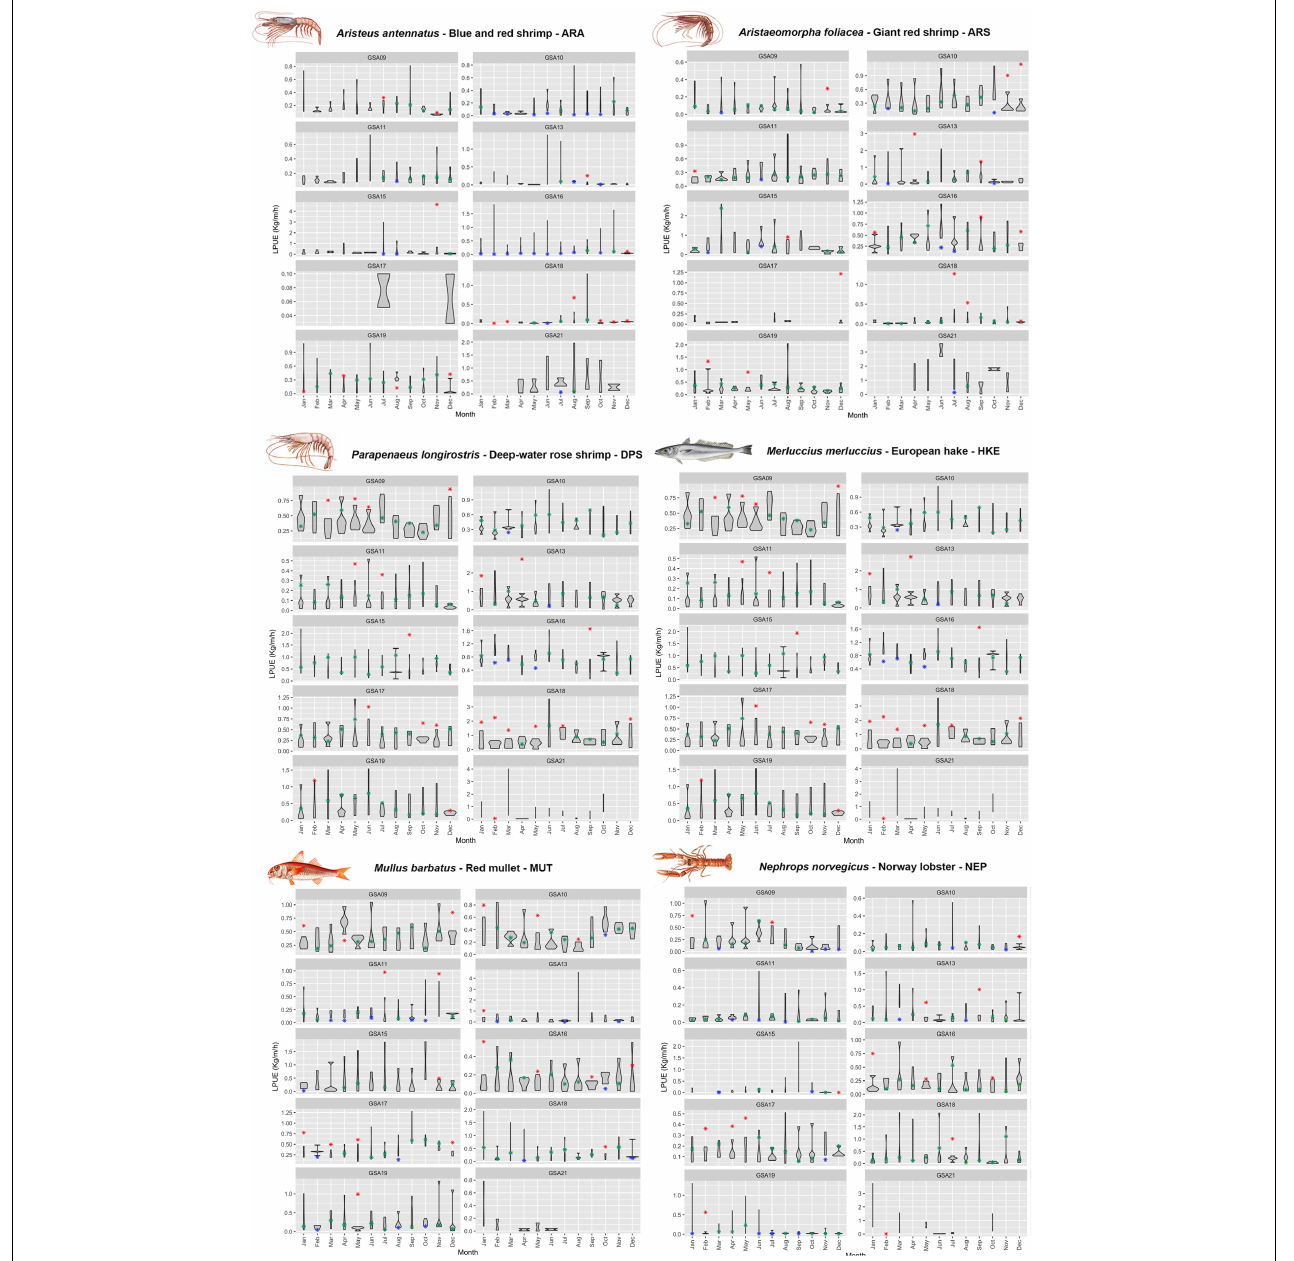
FIGURE 9 | Violin plot of the values of LPUE per species, month and GSA. The values of the years 2015–2019 are represented by the violin, while medians of the year 2020 (affected by the pandemic) are represented as red